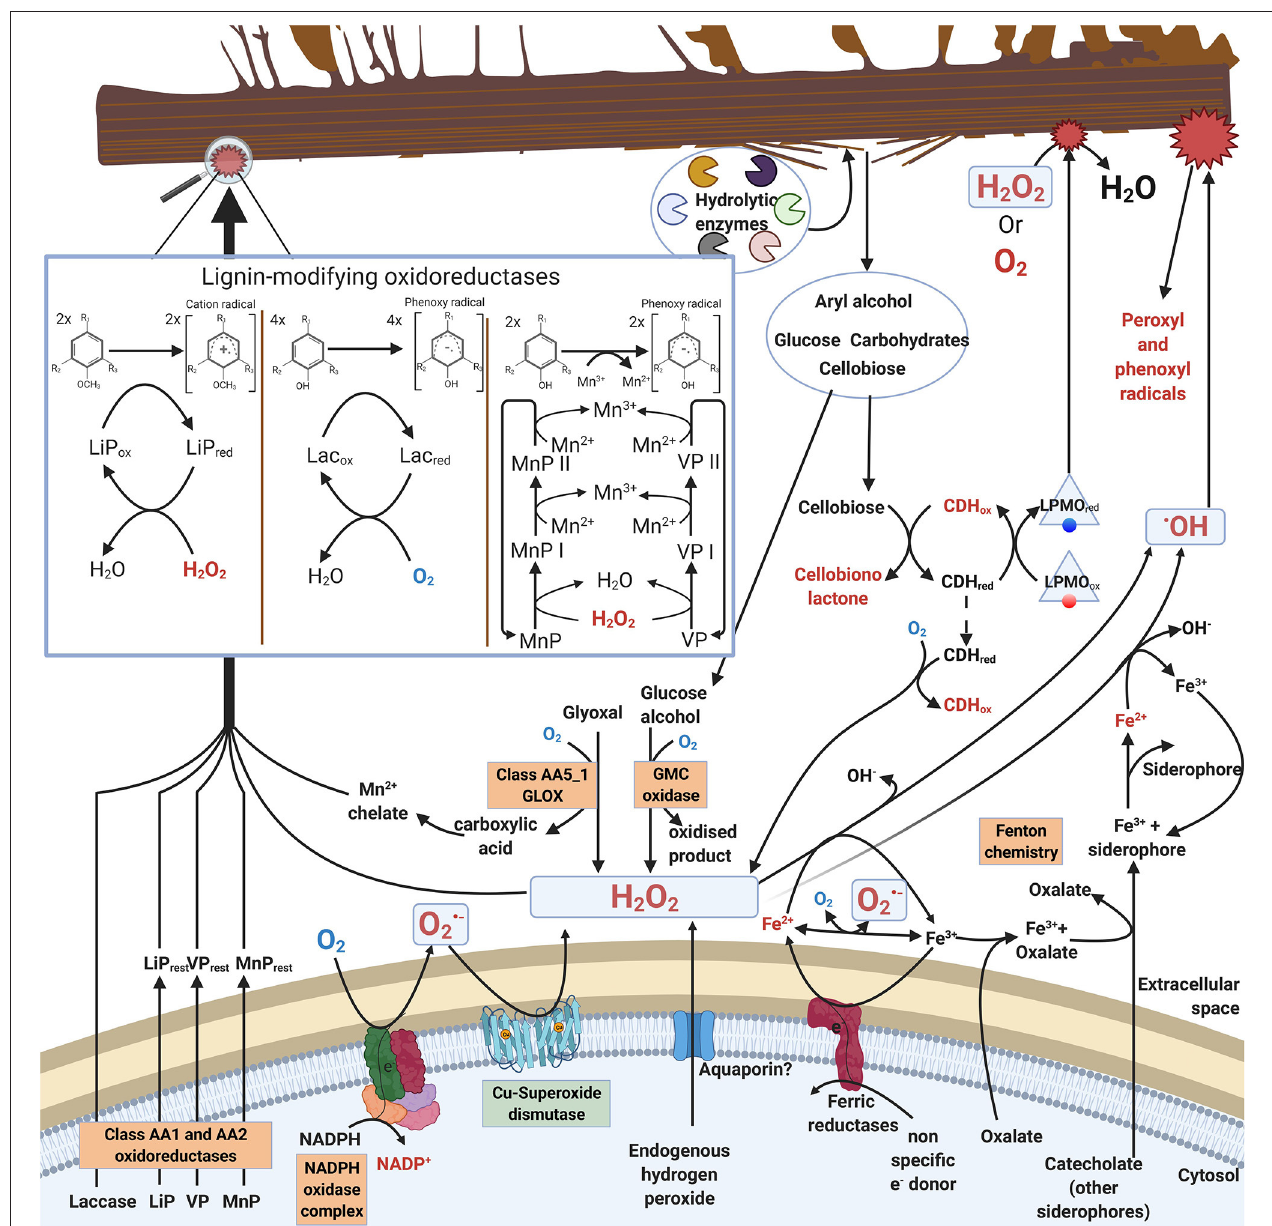
FIGURE 1 | Extracellular ROS formation in fungi of Basidiomycota illustrating reactions and enzymes involved. For clarity, stoichiometry is not included in the catalytic reactions. Boxed enzymes are discussed in the text.